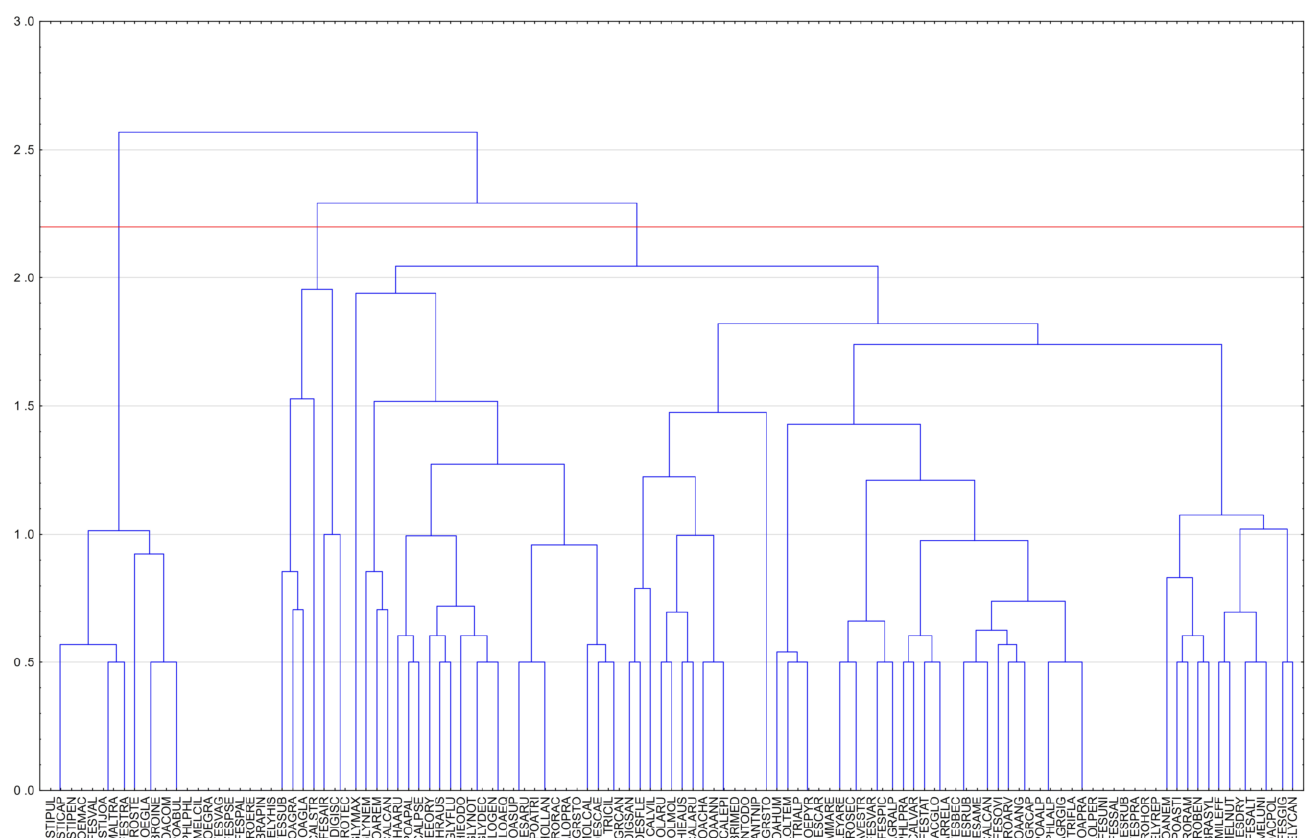
Figure 5. Different groups of CWR grass species occurring in Poland according to the Ellenberg indicator values.